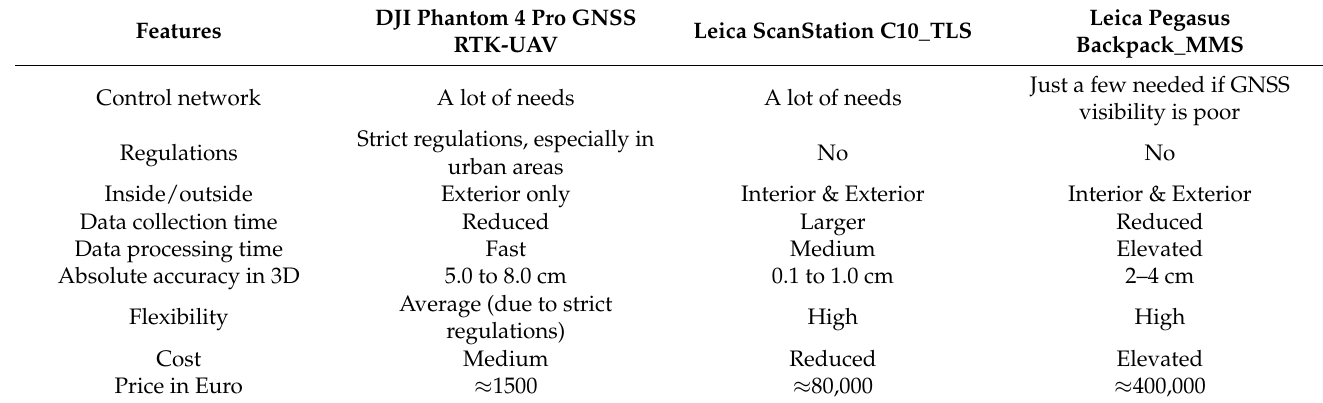
Table 18. Comparisons between UAV, TLS and MMS equipment.